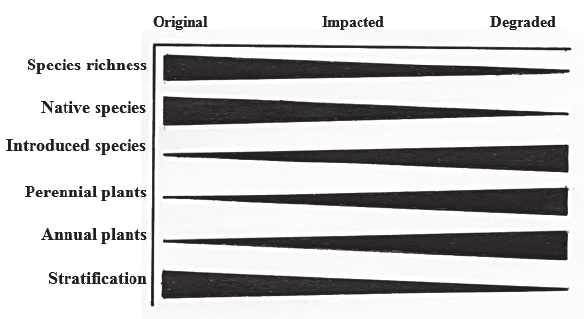
Figure 1. Changes in species richness and vegetation structure (increase or decrease) due to landscape degradation in South Central Chile (after Ramírez et al .,